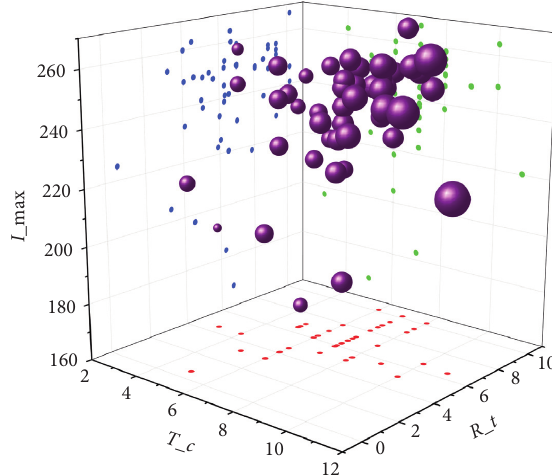
Figure 8: The start-up time of overlapping ( t _1) -rework time ( R _ t ) – revenue ( I